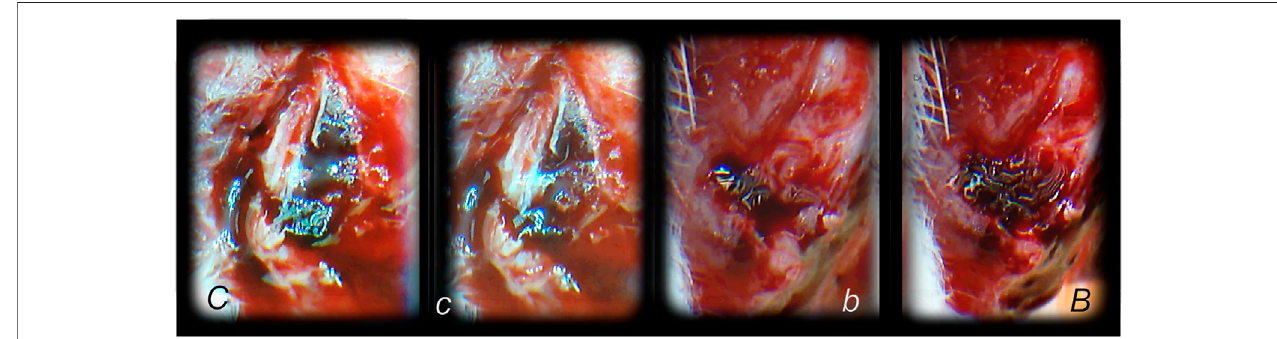
FIGURE 5 | Hematoma formation following tibial diaphysis fracture and BPC 157 therapy effect, in analogy with accomplished all four events (vessel constriction, the primary platelet plug, the secondary plug, and resolution of the clot) that occur in a set order following the loss of vascular integrity (Stupnisek et al., 2012) involved in the wound healing. We suggest BPC 157 healing starting with a rapid formation of the adequate hematoma as a connective scaffold between the stumps. BPC 157 (10 ng/kg) was given as a 1-ml bath to the injury, immediately after injury induction. Controls simultaneously received an equal of saline as a bath to the injury. At